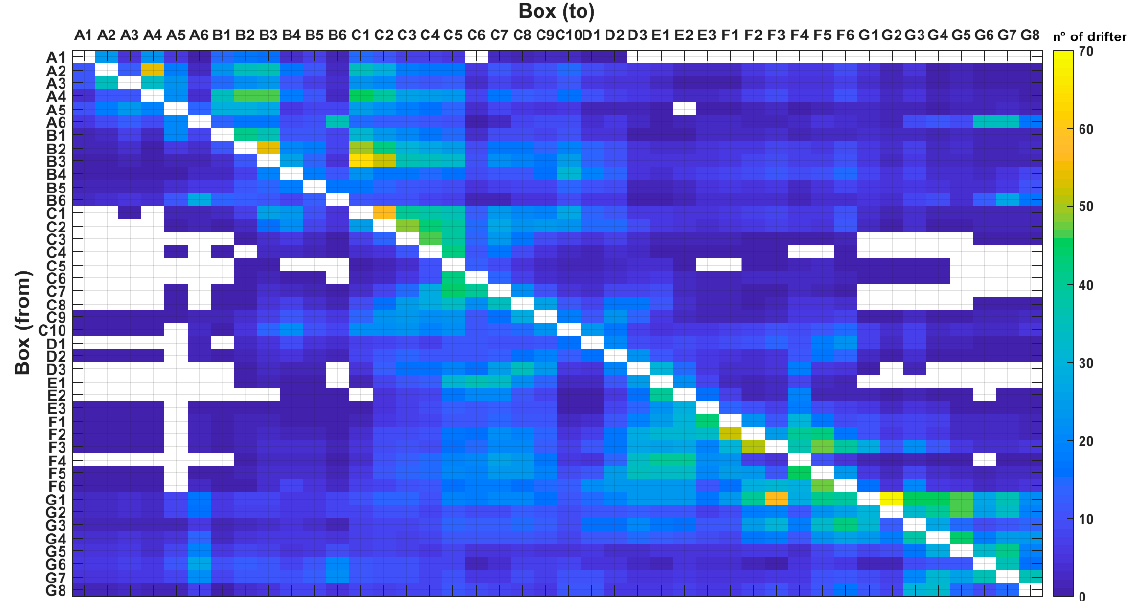
Figure 5. Number of drifters connecting the 42 boxes of the Western Mediterranean basin (WMED). Each box extends over a 1° × 1° cell. Drifter data refer to the 1985–2016 period.